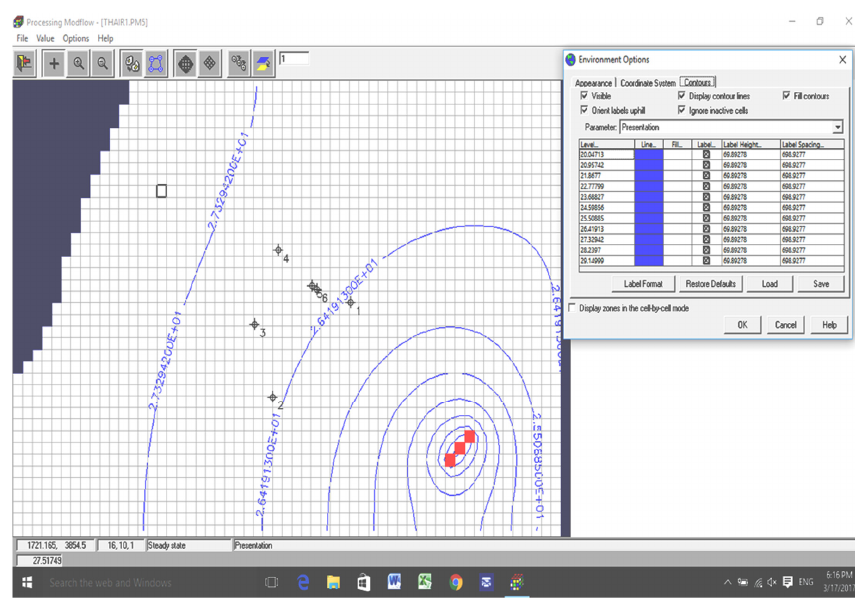
Figure 5. Groundwater equipotential contour lines for Scenario 2.